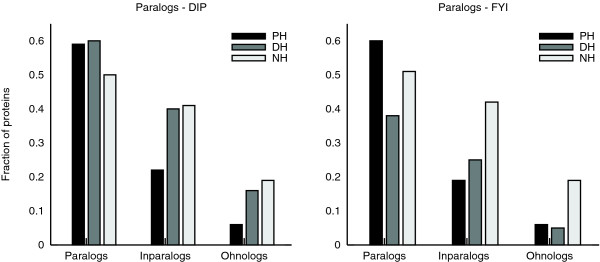
Paralogs. Fraction of proteins, that is, party hubs (PHs), date hubs (DHs) and non-hubs (NHs), that have paralogs, inparalogs (i.e. paralogs that have been duplicated after the split between S. cerevisiae and S. pombe) and ohnologs (paralogs resulting from the whole genome duplication). In DIP, the fraction of party hub inparalogs is small, approximately 0.2 compared to approximately 0.4 for the other connectivity groups (P value <10-5), and so is the fraction of ohnologs for party hubs compared to the other groups (P value <10-5). The results in the FYI data set are similar, although the fraction of date hub paralogs is smaller than in the DIP data set.